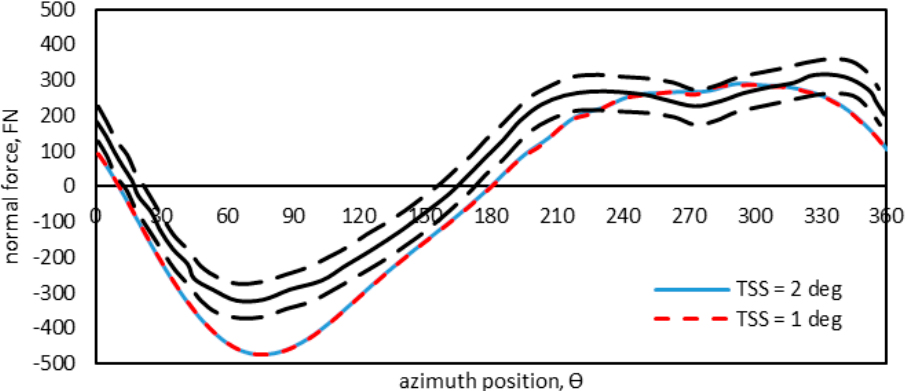
Figure 10. Airfoil normal force comparison between experimental data at time step sizes of 1° and 2° equivalent rotation.